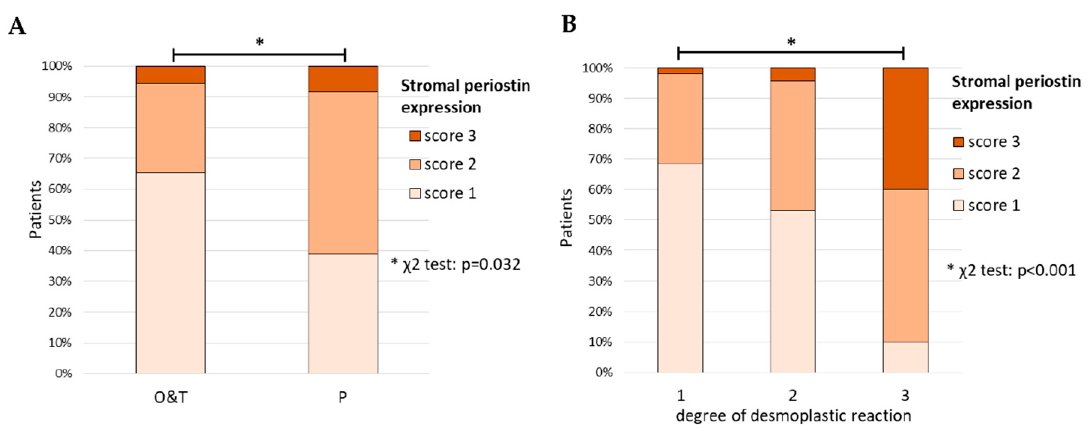
Figure 6. ( A ) Correlation between periostin expression and the anatomical source of tumor specimen ( χ 2 test, p = 0.032). P—samples derived from peritoneal/omental metastatic disease; O—primary tumor samples (containing visible ovarian structures); T—samples containing only tumor tissue; ( B ) Correlation between stromal periostin expression and the degree of desmoplastic reaction ( χ 2 test, p < 0.001). *—denotes p < 0.05.